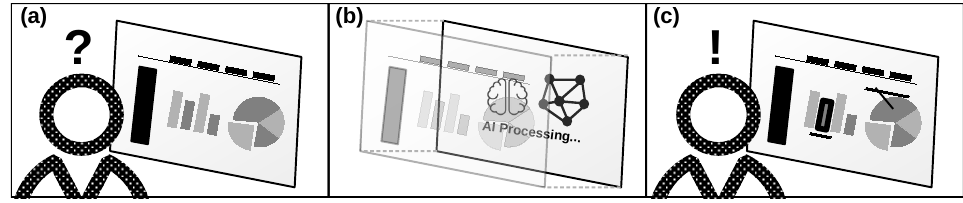
Figure 1. AI2VIS4BigData user empowerment user journey [5]. ( a ) Overstrained user; ( b ) AI application; ( c ) communication of insights as user